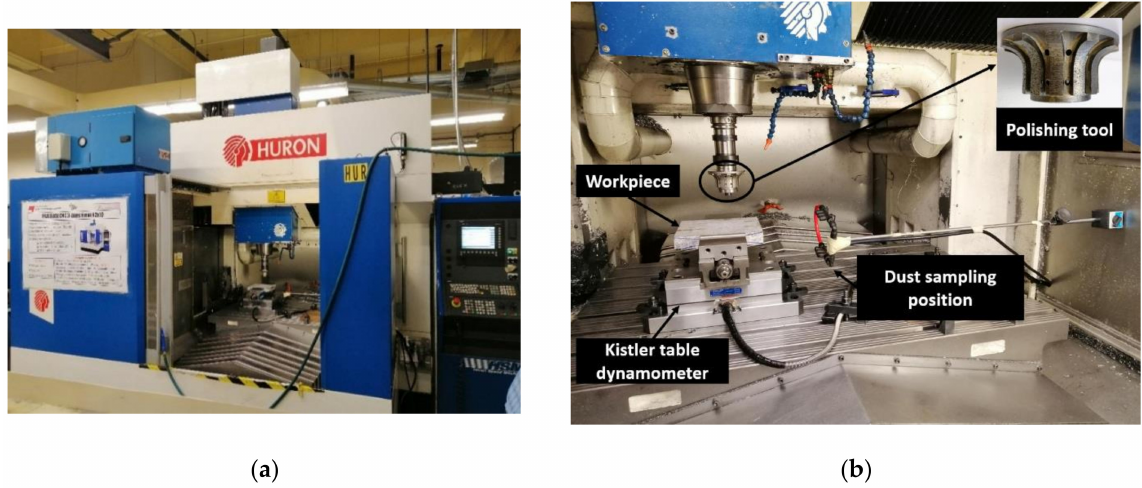
Figure 1. Experimental environment: ( a ) CNC grinding machine, ( b ) experimental setup. The acquisition of micrometric particles ranging from 0.5 to 20 µ m was carried out using an Aerodynamic Particle Sizer (APS) spectrometer (APS, model 3321, TSI Inc., Shore- view, MN, USA) as seen in Figure 2a, while the Scanning Mobility Particle Sizer (SMPS) (SMPS, model #3080, TSI Inc., Shoreview, MN, USA) measured the size distribution of nanometric particles as displayed in Figure 2b. This device (SMPS) can capture particles from 2.5 to 1000 nm diameter, but in this study, we limited the range between 2.5 and 333 nm. The time duration of collecting the particles was set at 50 s for both APS and SMPS equipment in all tests performed on granite pieces. At the end of the sampling time, the APS and SMPS provided data consisting of particle concentrations (numbers, mass, and surface) as a function of the particle diameters and the total mass concentration recorded.